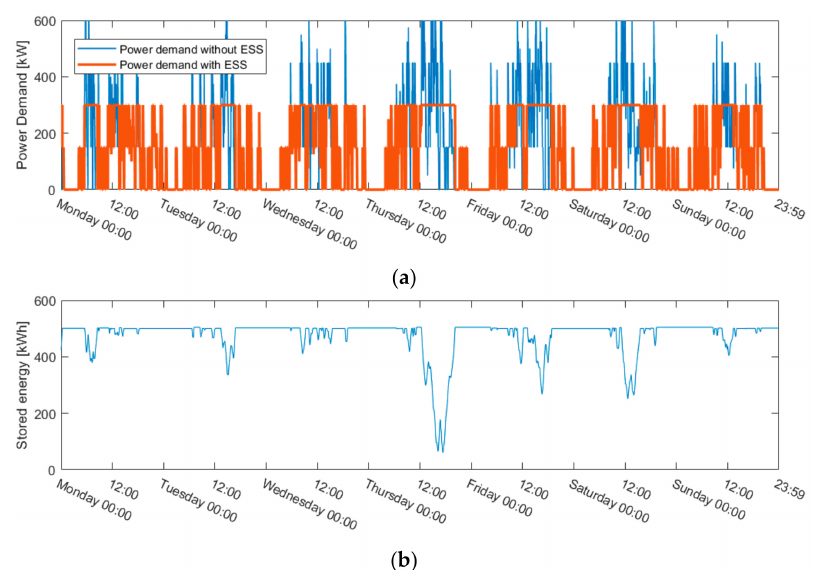
Figure 4. ESS operation ( a ) and variation of energy level in the ESS ( b ) during a week with 500 charging events and 4 charging